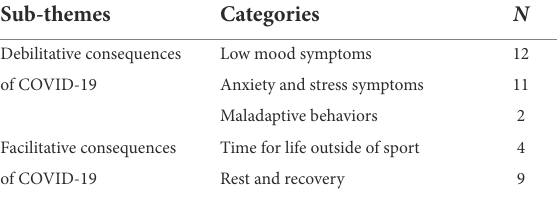
TABLE 3 The consequences of COVID-19 for